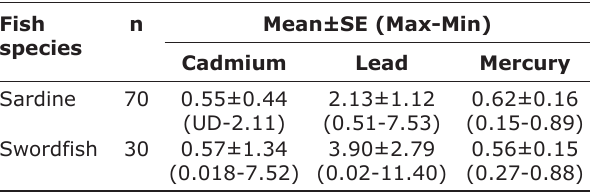
Table-2: Variations in cadmium, lead, and mercury concentrations in sardine and swordfish flesh (mg/kg fresh